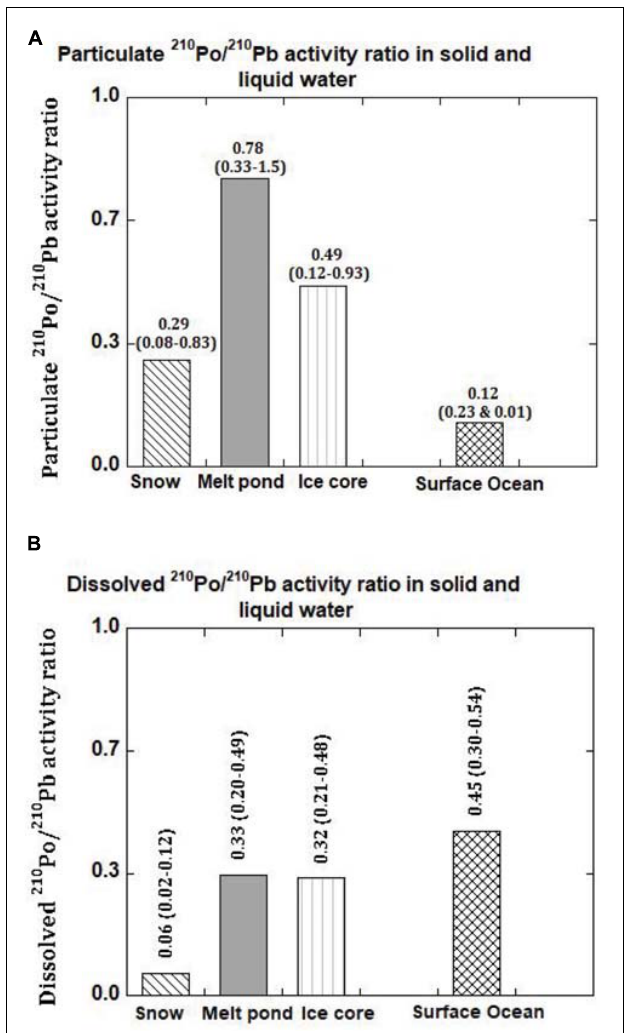
FIGURE 3 | (A) 210 Po/ 210 Pb activity ratio in the particulate matter in snow, melt pond, ice core and surface ocean in the Arctic. The mean values are given and numbers in parenthesis denote the range (US GEOTRACES Arctic cruise, HLY 1502, R/V Icebreaker USCGC Healy). (B) 210 Po/ 210 Pb activity ratio in the dissolved phase in snow, melt pond, ice core and surface ocean in the Arctic. The mean values are given and numbers in parenthesis denote the range (US GEOTRACES Arctic cruise, HLY 1502, R/V Icebreaker USCGC Healy).